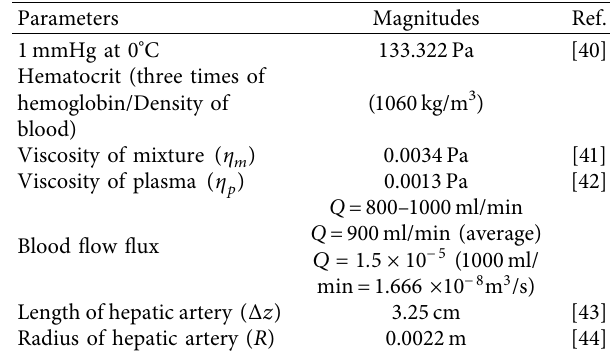
Table 2: Clinical data of jaundice patients (name: A , age: 43, and sex: